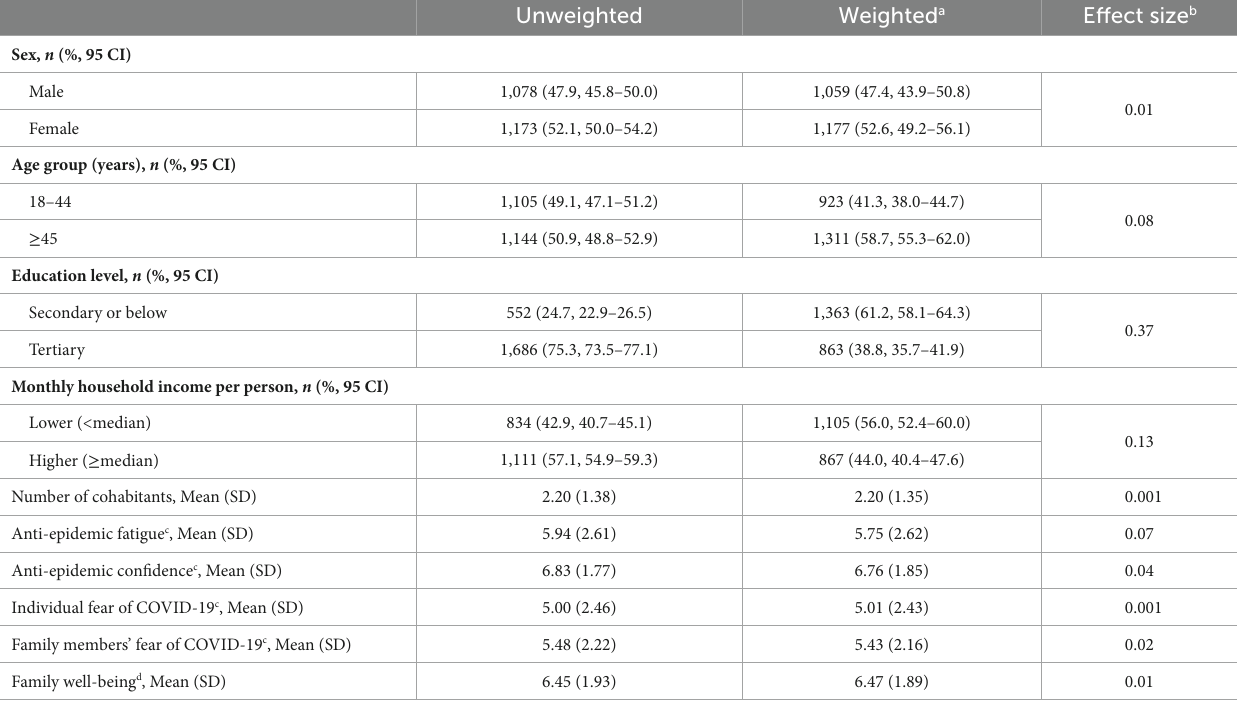
TABLE 1 Descriptive statistics of socio-demographic characteristics, individual and family